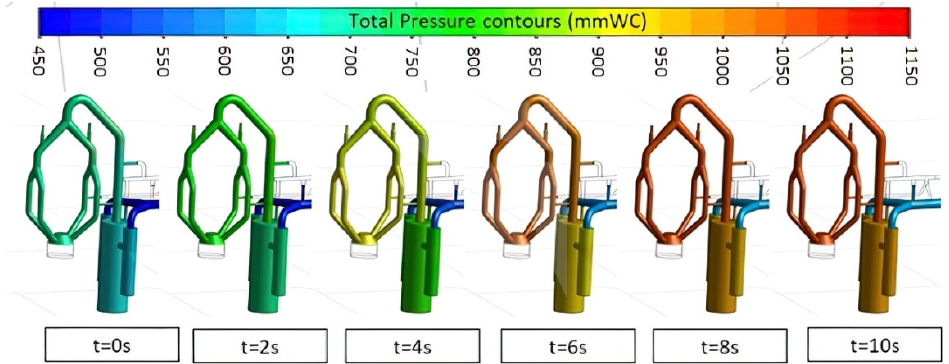
Figure 10. Evolution over time of pressure measures along the original circuit in the hypothesis there are no bleeders.